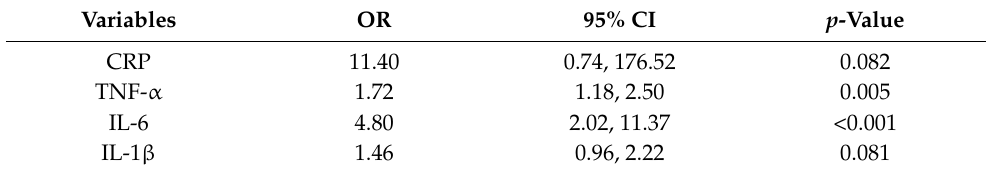
Table 5. Association between plasma inflammatory markers and depressive symptoms ( n = 123).